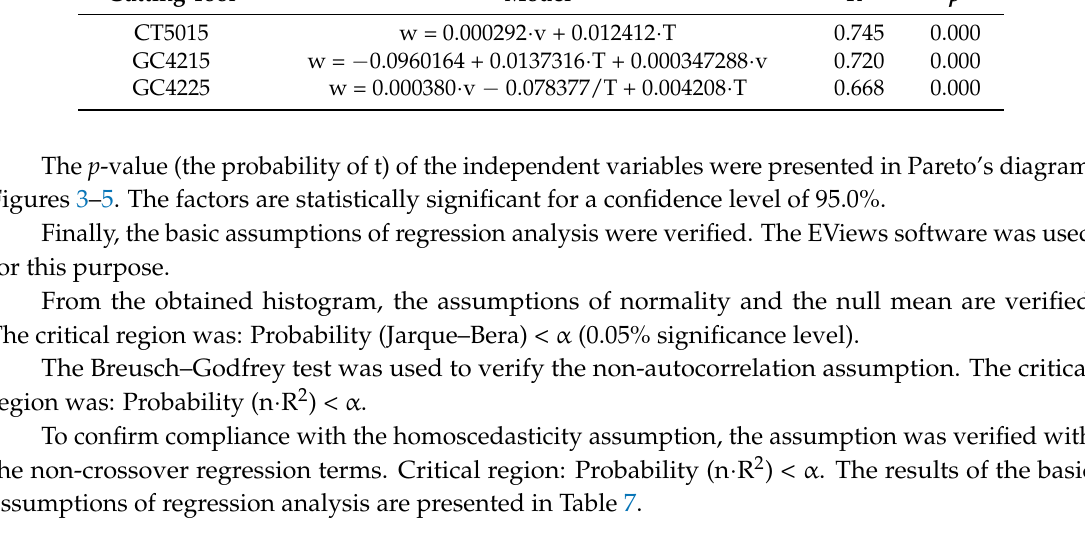
Table 6. Coefficient of determination and p -value of the analysis of variance of the models. Cutting